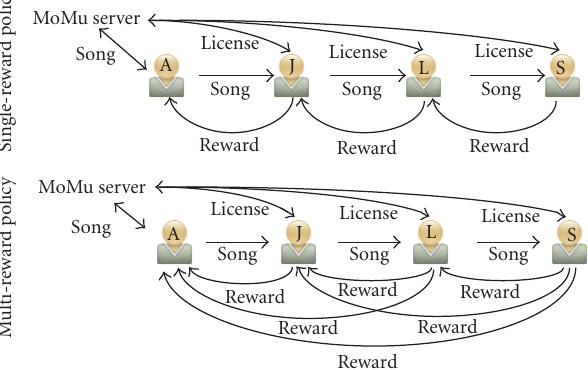
Figure 4: Di ff erence between a single- and a multireward policy. In the single-reward policy the additional financial cost is given back to who successfully distributed the song; in the multireward policy the additional financial cost is split among all the members that successfully distributed the